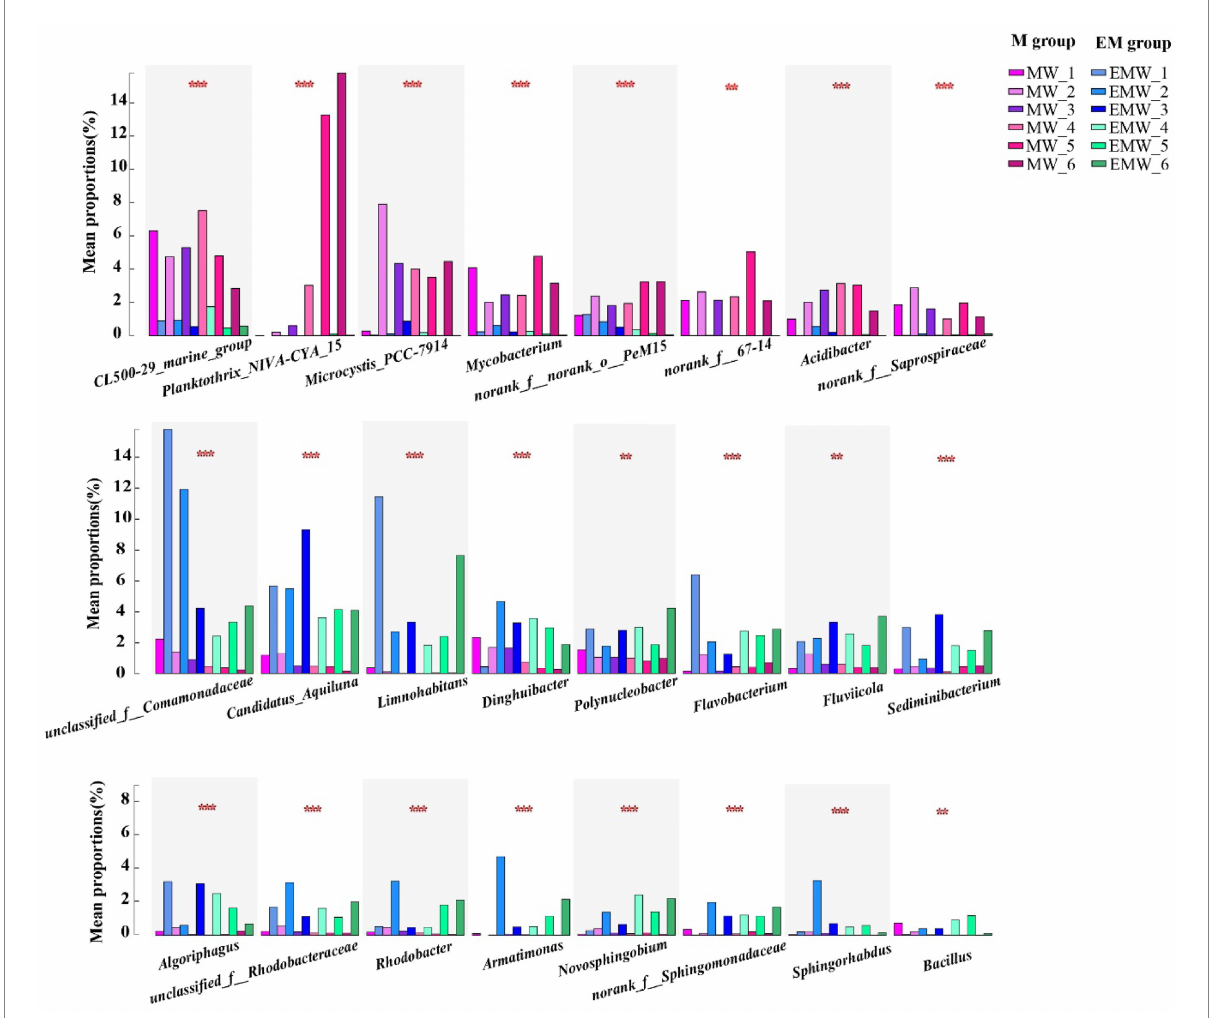
FIGURE 8 Statistical comparative analysis of relative abundance. * p < 0.05; ** p < 0.01; *** p <